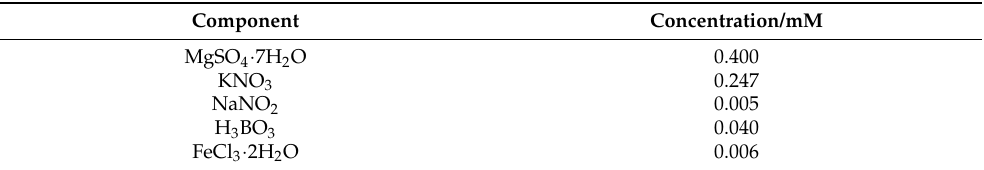
Table 1. Composition of modified A. obliquus culture medium added to the supersaturated calcium carbonate solutions upon inoculation with the